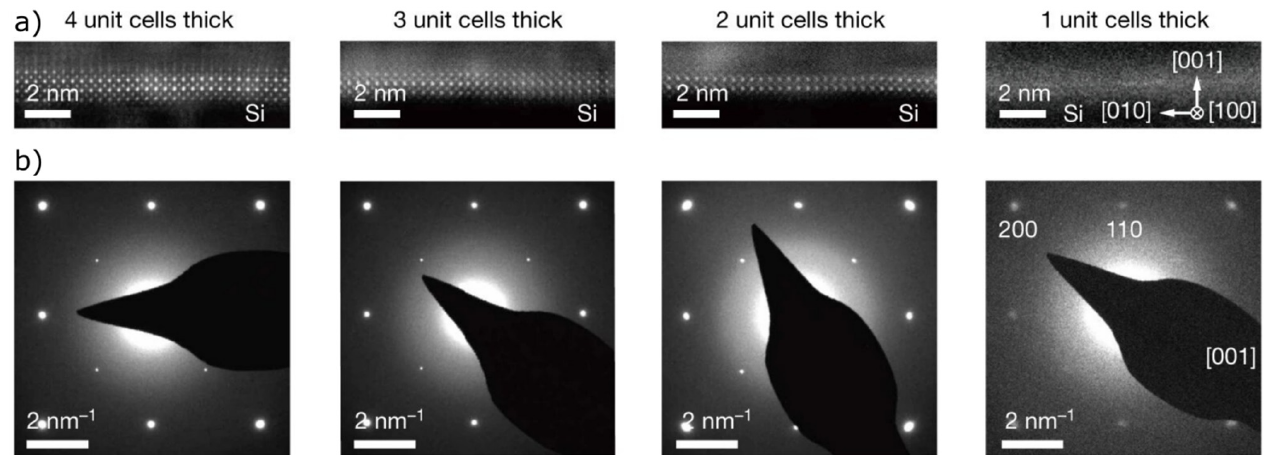
Figure 1. ( a ) Cross-sectional high-angle annular dark-field (HAADF) images and ( b ) selected area electron diffraction (SAED) patterns of ultra-thin, free-standing SrTiO 3 films of different unit cell thicknesses. Reprinted from Ji et al. [26] by permission from Springer Nature. Copyright 2021.